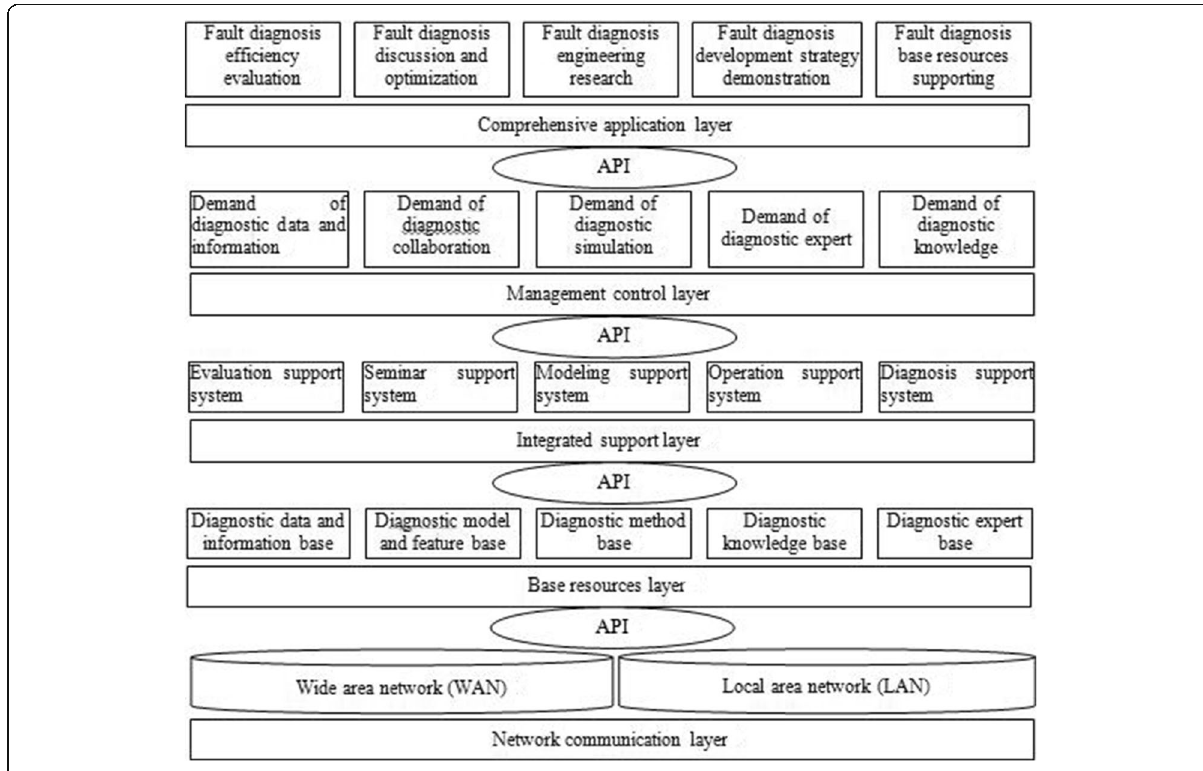
Fig. 3 Structural layer of fault diagnosis system